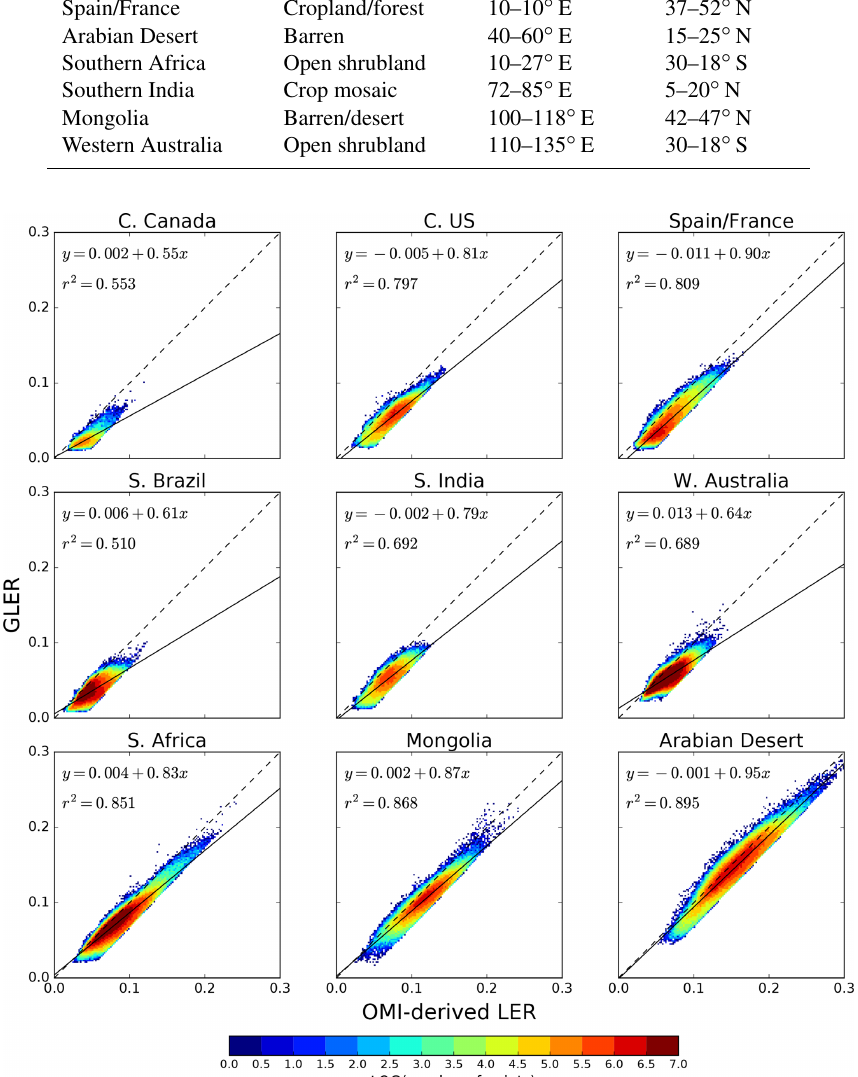
Figure 5. Comparison of aerosol and cloud-cleared OMI-derived LER at 466nm and GLER for 2006 across various geographical regions. In the color-bar legend, N is the number of